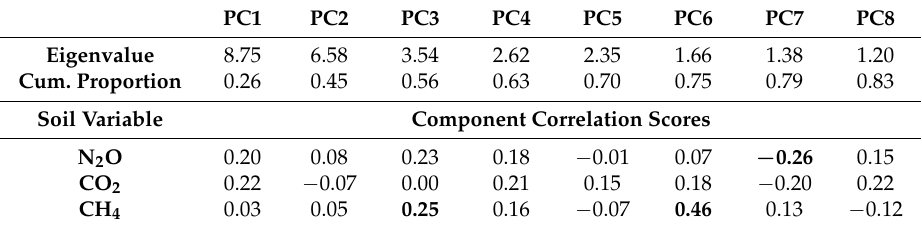
Table 3. Principal component analysis based on 32 observations modeling the yield index with 34 variables, with eigenvalues and cumulative proportion of the dataset variability explained by the eight principal components (PC) extracted with eigenvalues >1. Component correlation scores (eigenvalues) with loadings greater than |0.25| are in